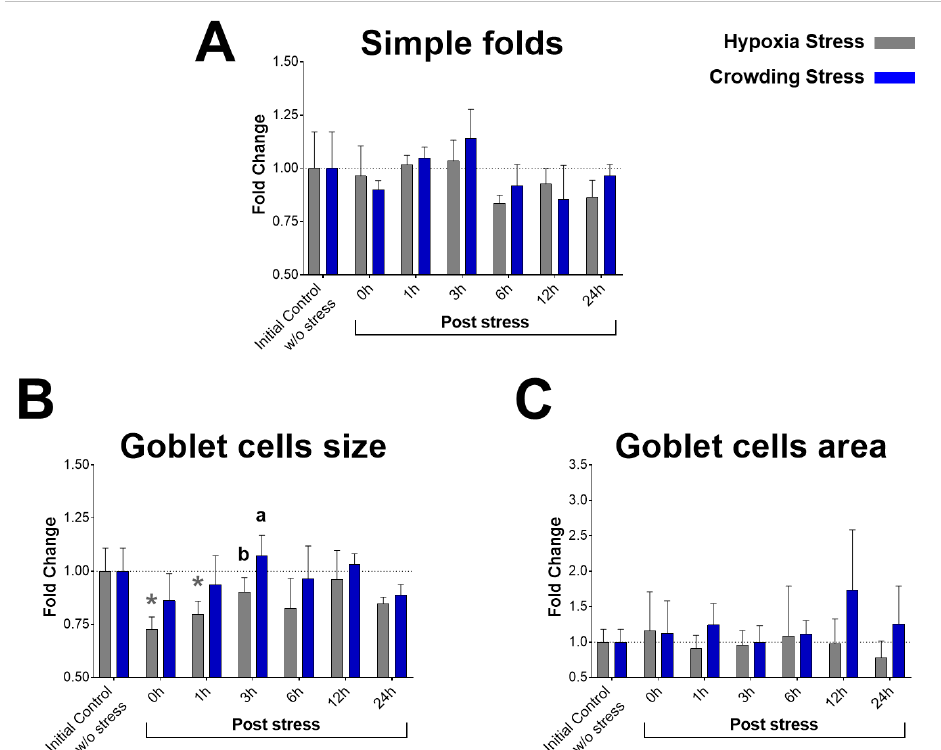
Figure 5. Morphometry of PAS-stained tissue sections of distal intestine from Atlantic salmon. ( A ) Simple folds length ± standard deviation in distal intestine. ( B ) Average size of goblet cells ± standard deviation in simple folds of distal intestine. ( C ) Percentage of area occupied by goblet cells ± standard deviation in epithelium of simple folds. Sampling groups: initial control group (without stress) and 0, 1, 3, 6, 12, and 24 h post-stress. In grey, hypoxia stress; in blue, crowding stress. Significant differences ( p < 0.05) are denoted with * (compared with initial control group) and with the letters a and b (compared between stress models).